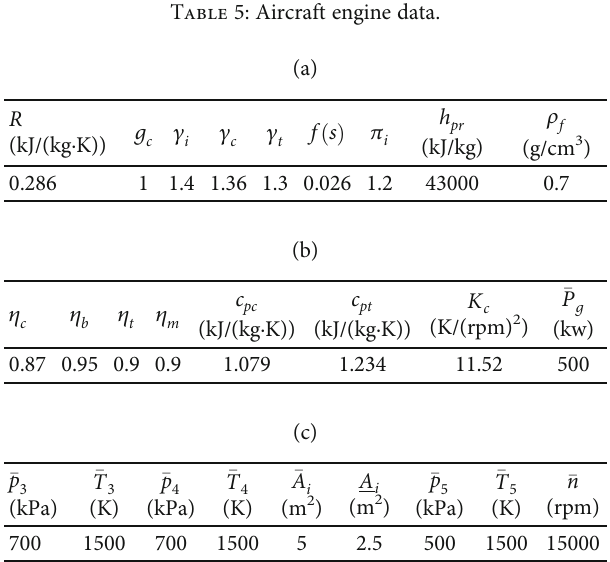
Table 5: Aircraft engine data.